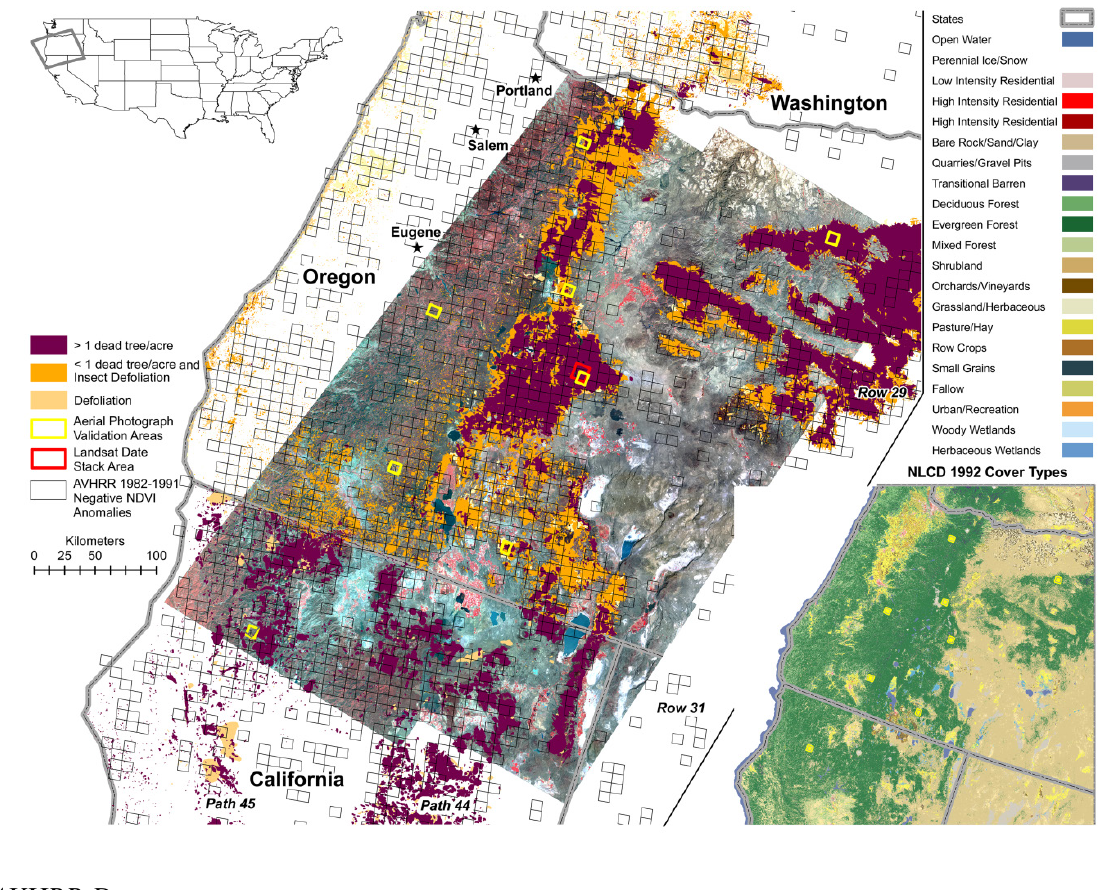
Figure 1. Global Inventory Modeling and Mapping Studies (GIMMS) Normalized Difference Vegetation Index (NDVI) anomalies with a negative trend less than − 0.05, for 1982 to 1991 (black boxes), overlaid upon Landsat images displayed in a 4,3,2 RGB band combination for 1992. An aerial insect disturbance survey from 1980 to 1994 (purple and orange) and aerial photo accuracy assessment sites (yellow boxes) are shown. The lower right inset displays the 1992 National Land Cover Data (NLCD) for the region with a legend of cover